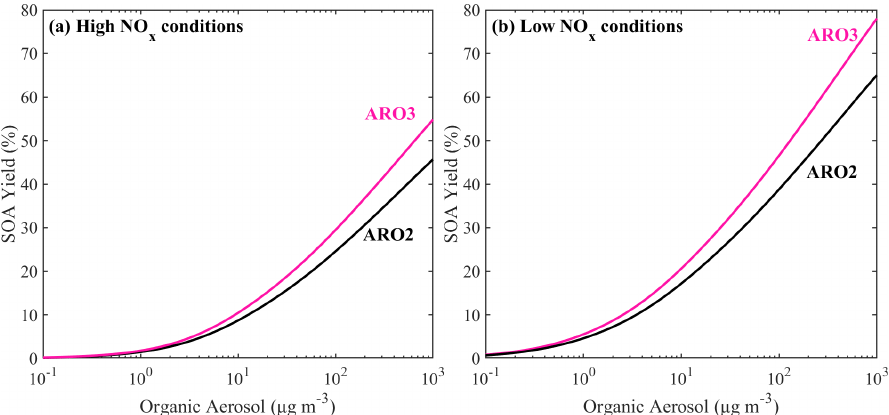
Figure 11. Estimated aerosol yields for the new aromatic species (ARO3) and the existing ARO2 species under (a) high-NO x and (b) low- NO x